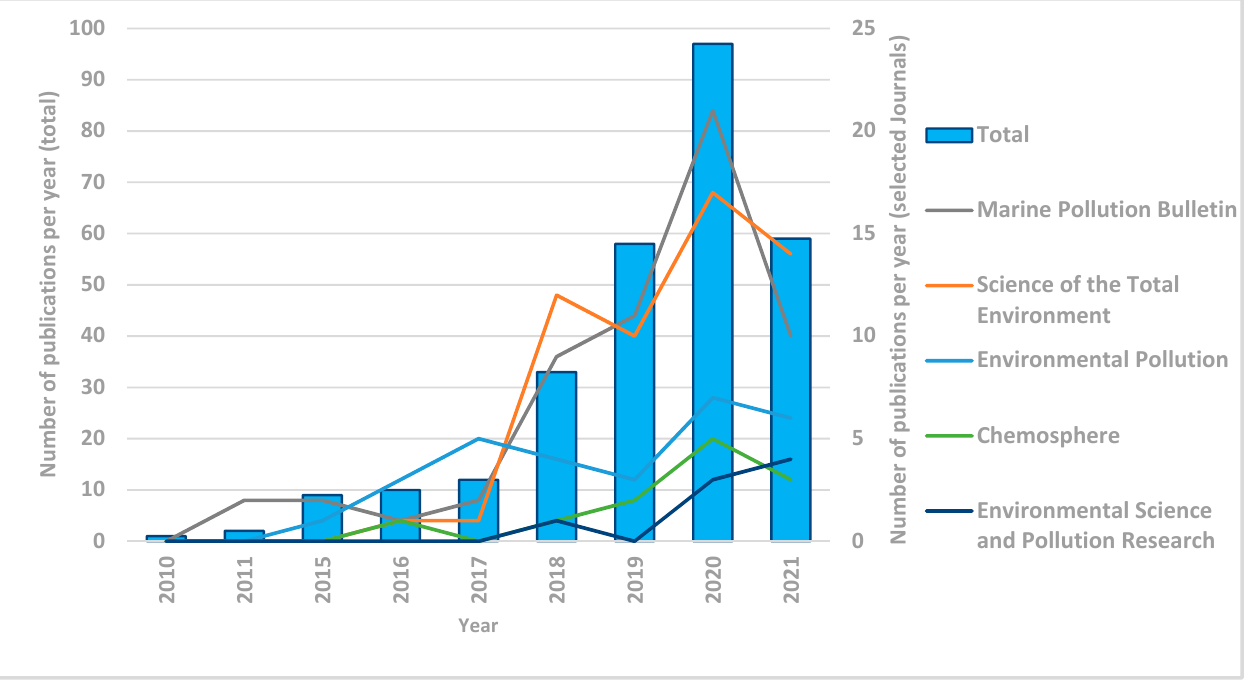
Figure 1. Number and percentage of publications per year in the last decade (total and most productive journals).